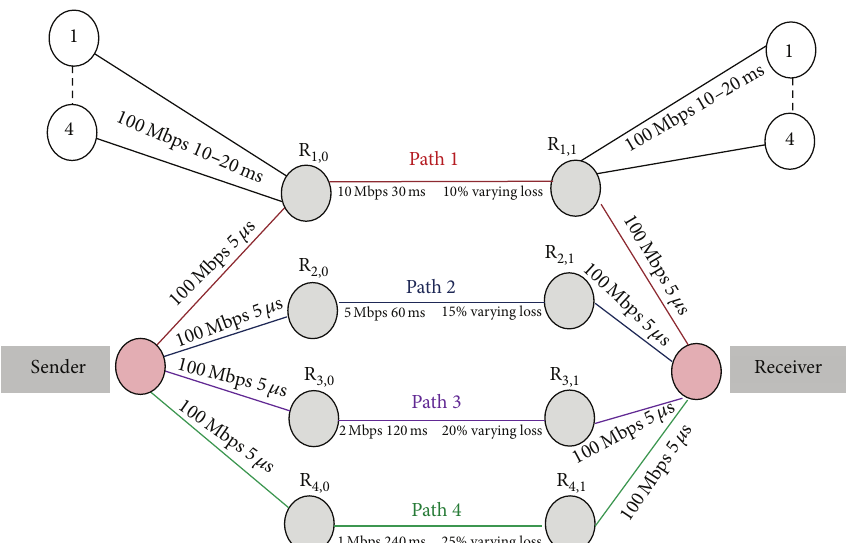
Figure 1: Simulation topology for validating algorithm.